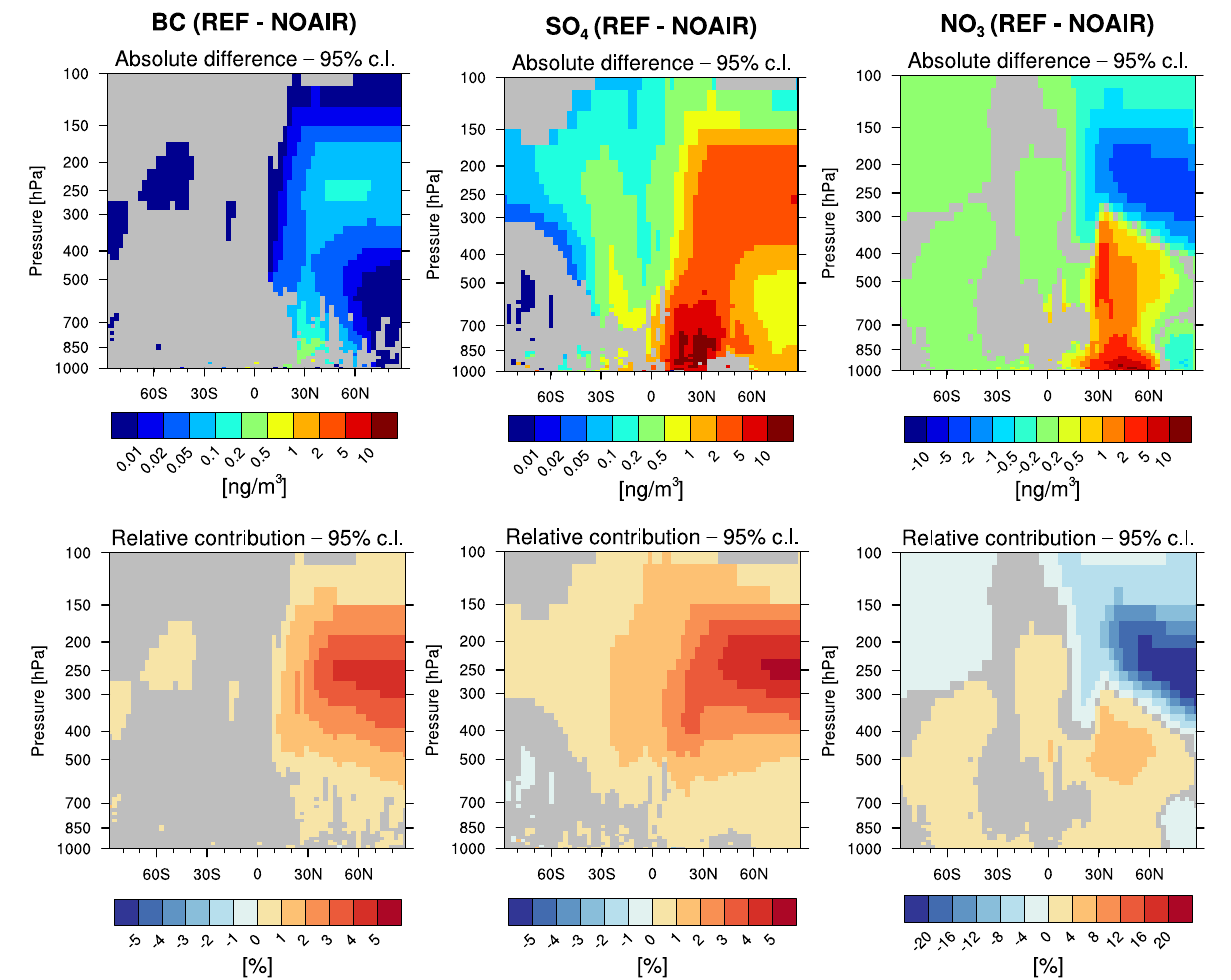
Fig. 6. Multi-year average (1996–2005) zonal means of the absolute (top) and the relative effect (bottom) of aviation on BC (left), SO 4 (middle) and aerosol nitrate (NO 3 , right) concentrations. Plotted are the differences between the experiments REF and NOAIR. The relative effect is calculated as the relative contribution (REF–NOAIR)/REF. Grid points where the difference is not statistically significant according to a uni-variate t test (5% error probability) are masked out in